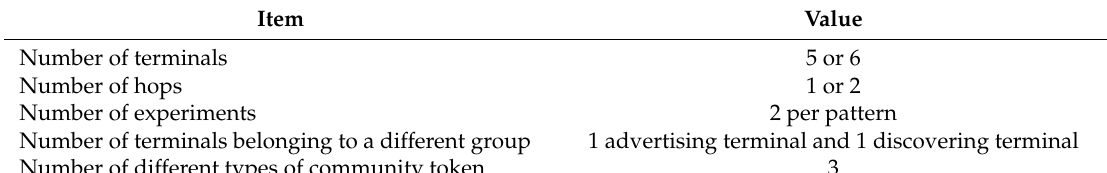
Table 10. Experimental conditions for a case where terminals belonging to different groups exist.